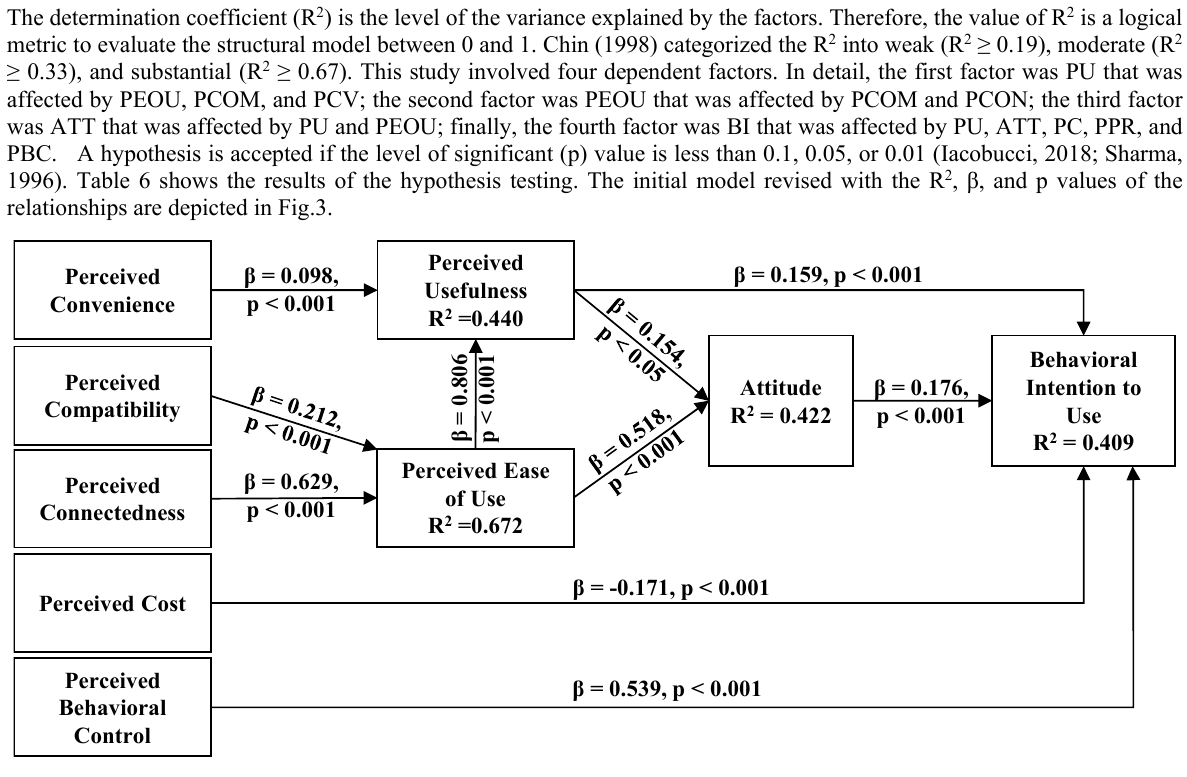
Fig. 3. An Extended Acceptance Model for